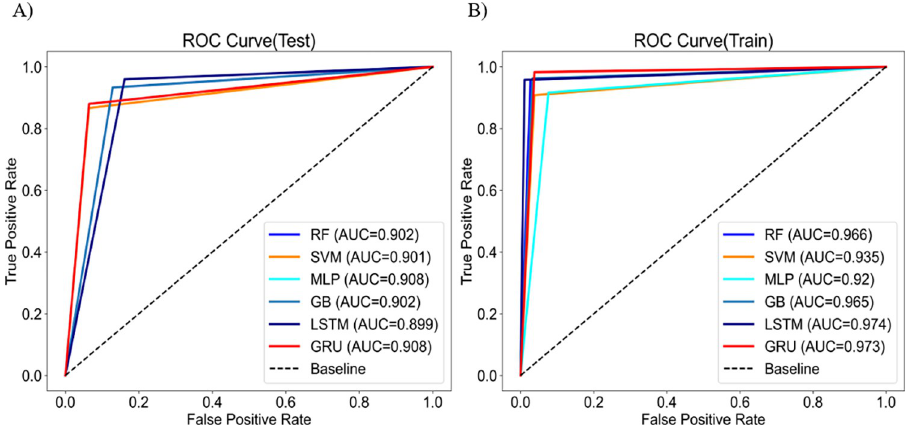
Fig 4. ROC curve comparing 6 machine learning algorithms for A ) train and B ) test